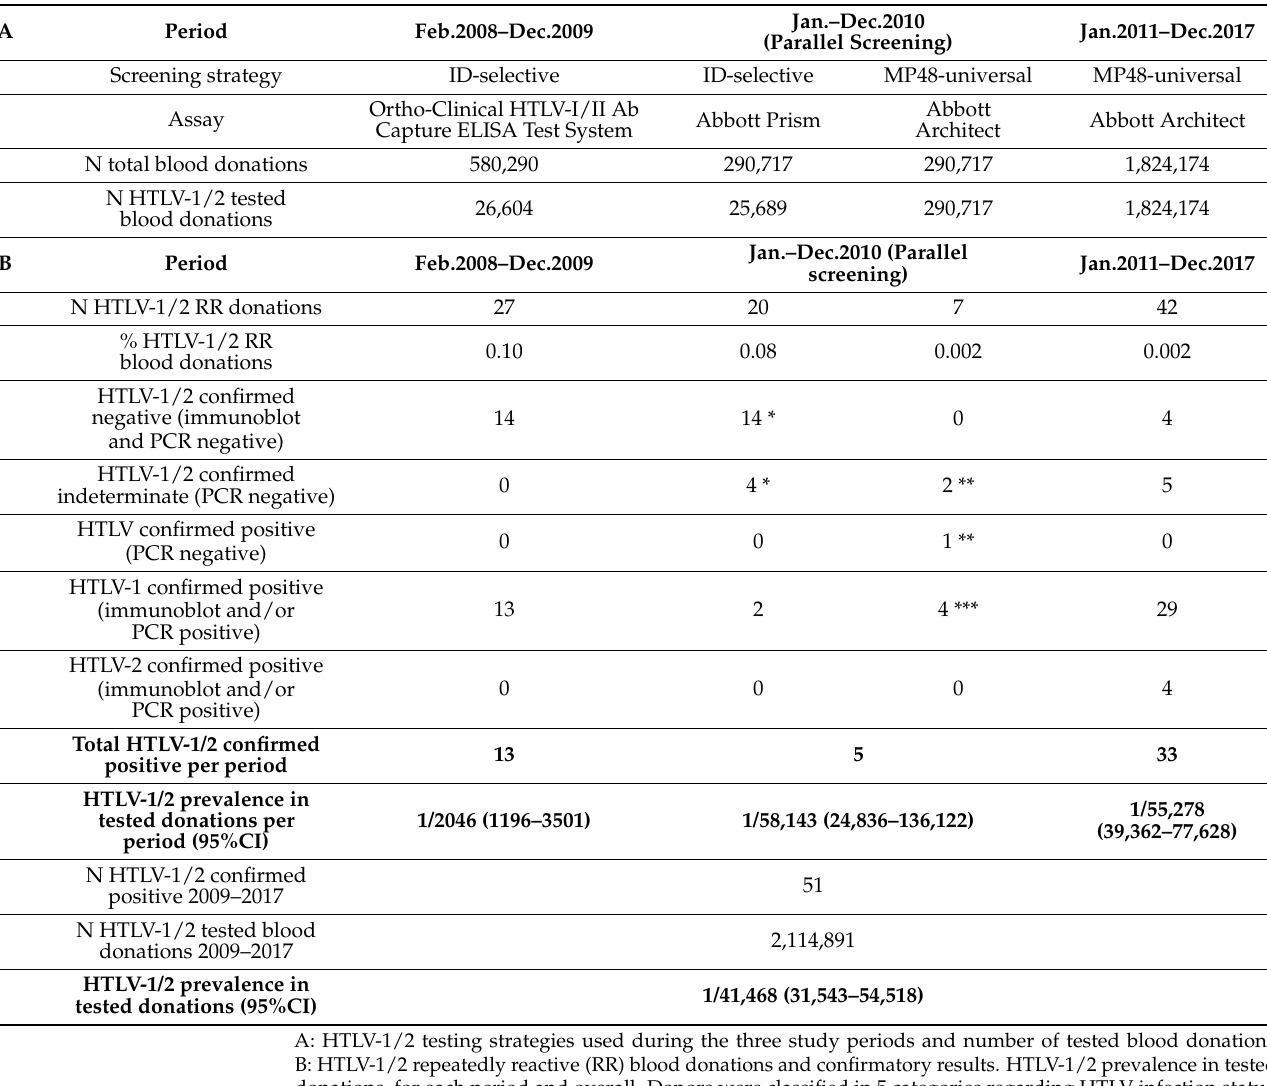
Table 2. HTLV-1/2 testing methods (A) and results (B) by period, February 2008–December